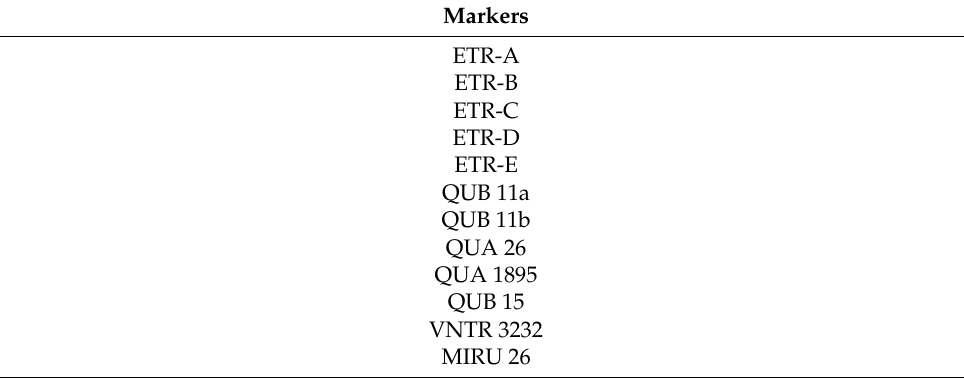
Table 1. Order of markers used to identify the genetic profile of the M. bovis strain used in the experimental contamination phase of this